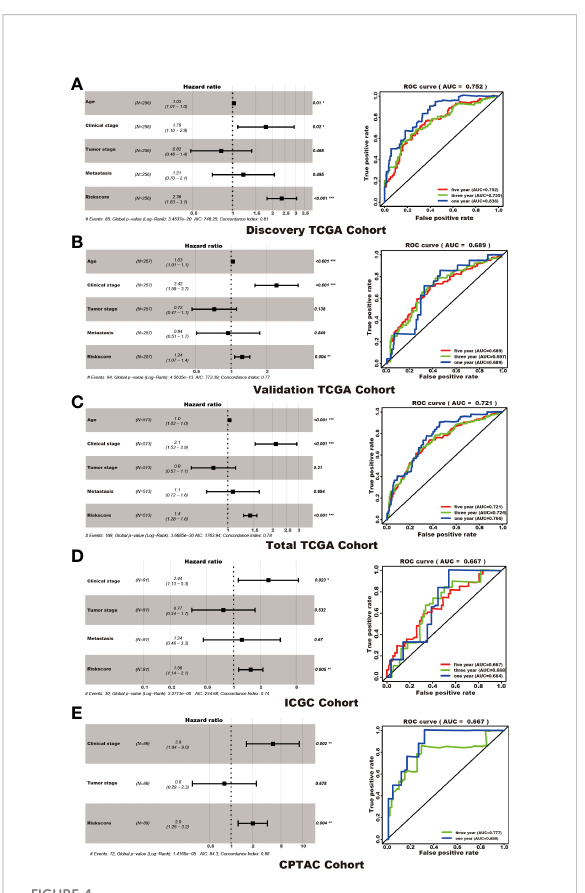
FIGURE 4 TRGs risk model as an independent prognosis factor in these fi ve cohorts. TRGs risk score, clinical stage, and age were the independent factors in the discovery TCGA cohort (A) , validation TCGA cohort (B) , and total TCGA cohort (C) . Clinical stage and TRGs risk score were the independent factors in the ICGC cohort (D) and CPTAC cohort (E) . The ROC curve and AUC value were also shown in each cohort. (*represents p<0.01, **represents p<0.01, *** represents